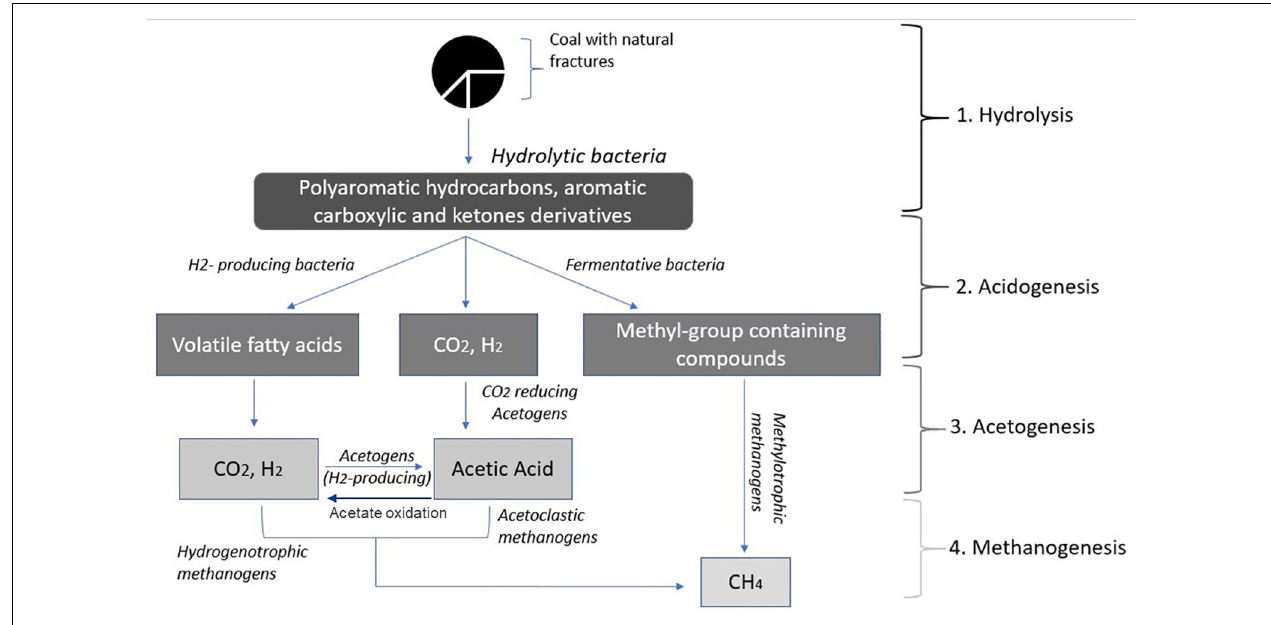
FIGURE 1 | Conversion of coal into methane (adapted from Stra¸po´c et al.,